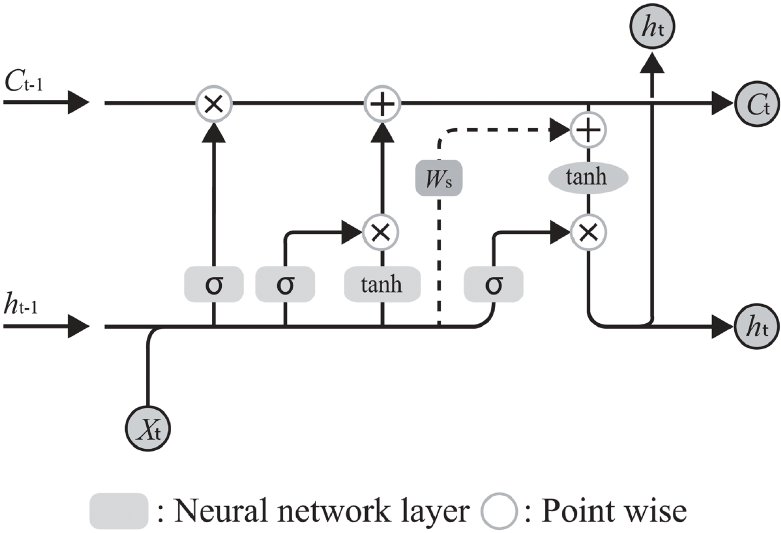
Fig 2. Architecture of LSTM with residual learning. Implementation of residual learning in LSTM with shortcut connection after forgetting of old information and addition of the new information. The dotted line shows shortcut